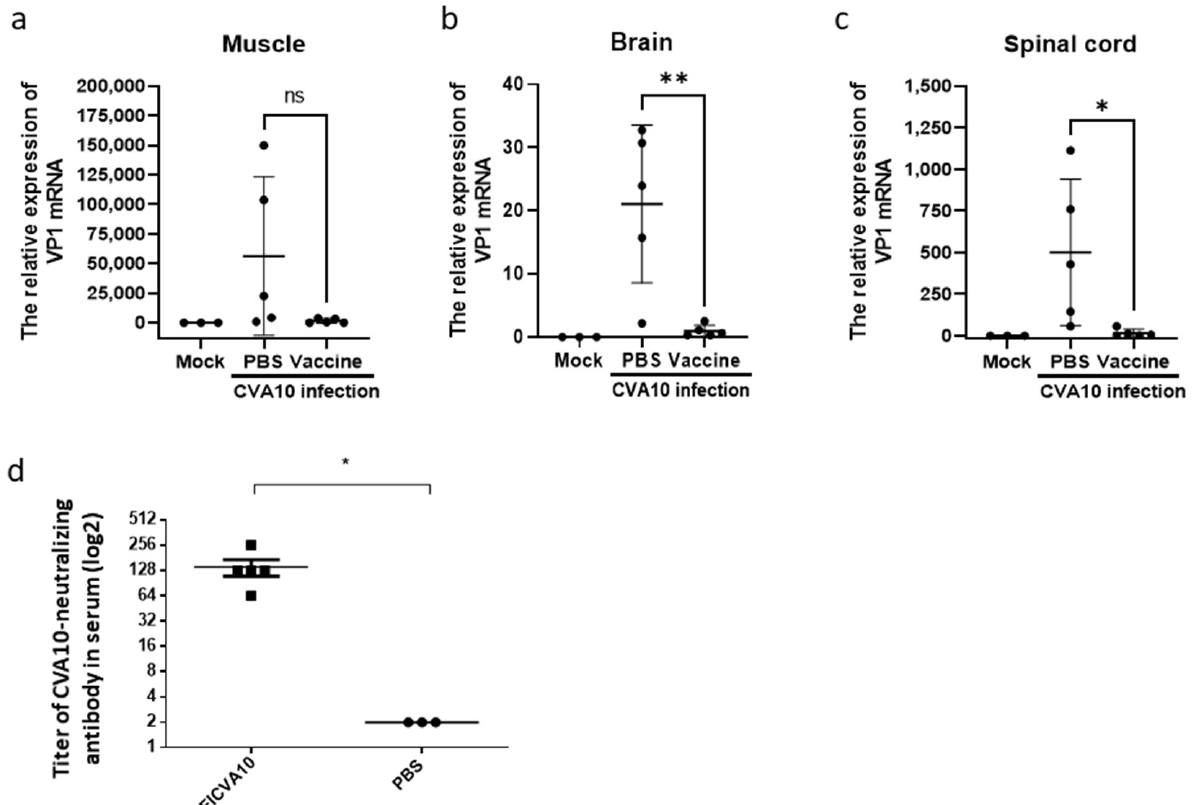
Figure 7. Reduction in viruses in the tissues of CVA10-infected mice pre-receiving FI-CVA10 vaccine. On day 3 post-viral infection, RNA was extracted from the ( a ) muscle, ( b ) brain, and ( c ) spinal cord of Tg mice, which had been pre-immunized with PBS or two-dose of FI-CVA10 (described in the legend of Figure 6), and were subjected to quantitative RT-PCR analysis using primers specific to the VP1 region. RNA from the same age of Tg mice without any treatment (Mock) as background control was included. β -actin gene expression in each tissue was used as the internal control to calculate the relative expression of VP1 mRNA. A schematic representation of the VP1 gene expression and the statistical average from five mice per group from the FI-CVA10-treated group and three mice per group from the PBS-treated group (minimizing the number of animals used in the test) is shown. ( d ) Tg mice (6–8 weeks old) pre-immunized with PBS or two-dose of FI-CVA10 at a 2-week interval. Serum samples collected from individual Tg mice on day 28 post the second shot of FI-CVA10 were assayed for the titer of anti-CVA10 neutralizing antibodies. The results were expressed as titers for each test sample. Bars correspond to the mean titers for each experimental group. The symbols *, **, and ns were used to indicate p < 0.05, p < 0.01, and no significant difference, respectively. The binding activity of FI-CVA10-immunized serum against CVA10 virions was ob- served (Supplementary Figure S3). The neutralizing antibody titer was significantly raised (>128) in the serum of mice immunized with FI-CVA10 compared to the serum of non- immunized mice (Figure 7d). Additionally, induction of splenocytic IFN- γ and IL-4 secre- tion was observed in the FI-CVA10-immunized mice (Supplementary Figure S4). These results support the induction of protective immunity by FI-CVA10 in newborn hSCARB2- Tg mice. Moreover, our findings demonstrate that hSCARB2-Tg mice serve as a reliable model to evaluate the efficacy of CVA10 vaccines, as the prototypic FI-CVA10 vaccine demonstrated effectiveness in preventing CVA10